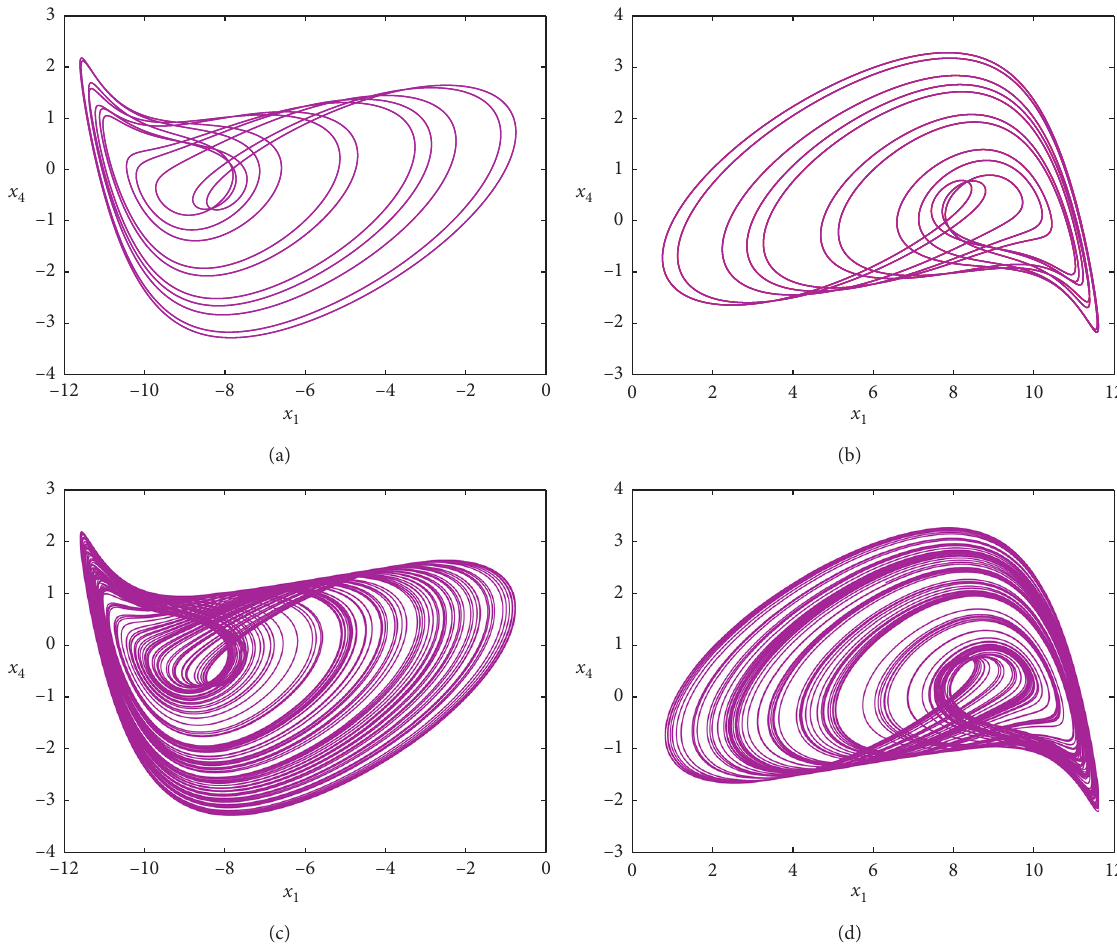
Figure 6: Coexistence of four attractors (a pair of period-11 limit cycle and a pair of chaotic attractors) with a � 17 . 04, and their cor- responding initial conditions are ( ± 4 . 8 , 0 , 0 , 0 ) and ( ± 1 . 2 , 0 , 0 , 0 )